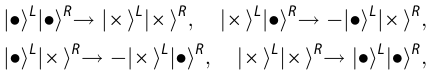
γ R γ L γ R B A þ B A